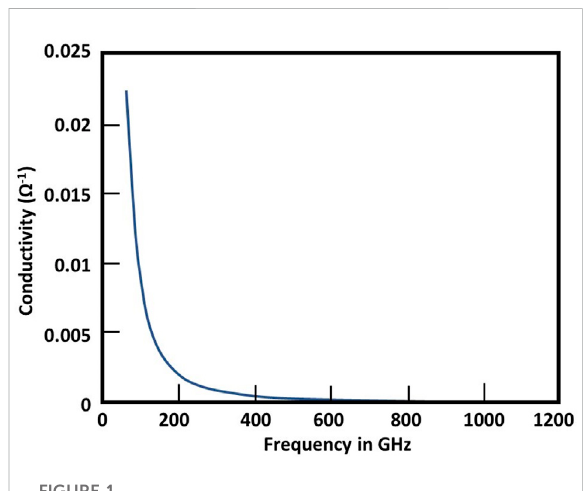
FIGURE 1 Graphene ’ s Conductivity vs. Frequency graph represented as by Kubo ’ s formula (Gusynin et al.,